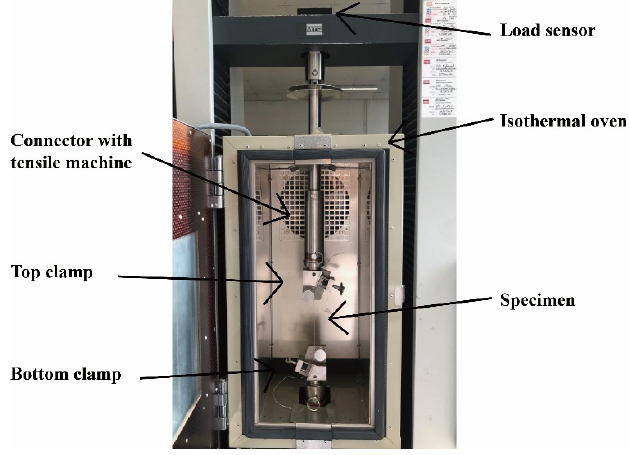
Figure 2. Thermo-state tensile test of single hybrid yarn.